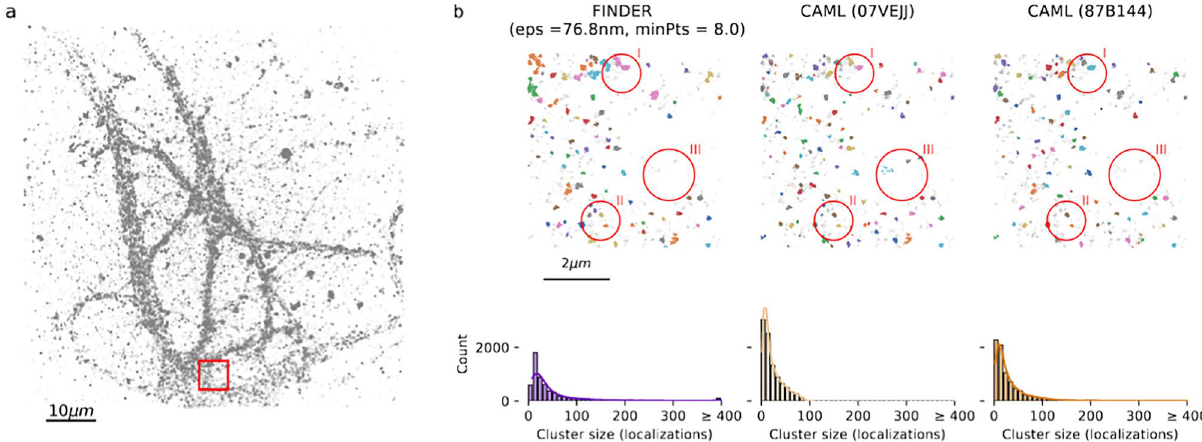
Figure 5. Analysis of newly synthesized proteins in neuronal dendrites in DNA-PAINT data 6 . Left: Localizations analyzed using FINDER, CAML (07VEJJ) and CAML (87B144) 33 . Right: The top row depicts a section of the full field of view corresponding to the red rectangle in the left panel. Detected clusters are highlighted as colored points and localizations that were classified as noise are shown as grey points. The optimal parameters identified by FINDER for DBSCAN (noisefree) for minPts = 8 are ε = 76.80 nm. FINDER, CAML (07VEJJ) and CAML (87B144) assigned 21.8% , 0% and 1.4% of all localizations to clusters with